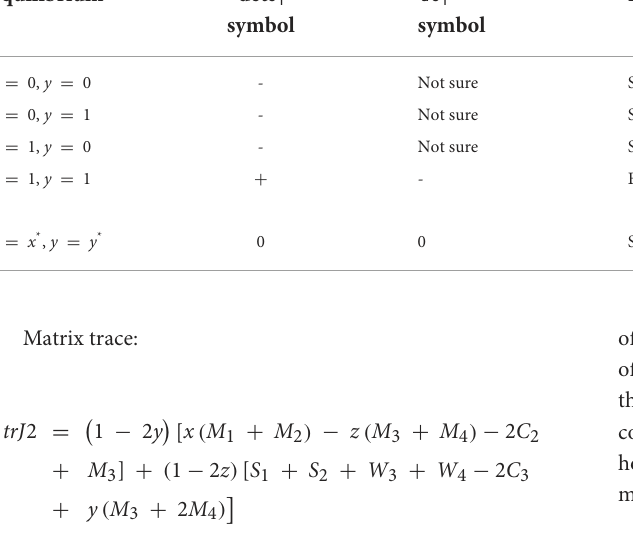
Table 3 indicates that stable points can be formed